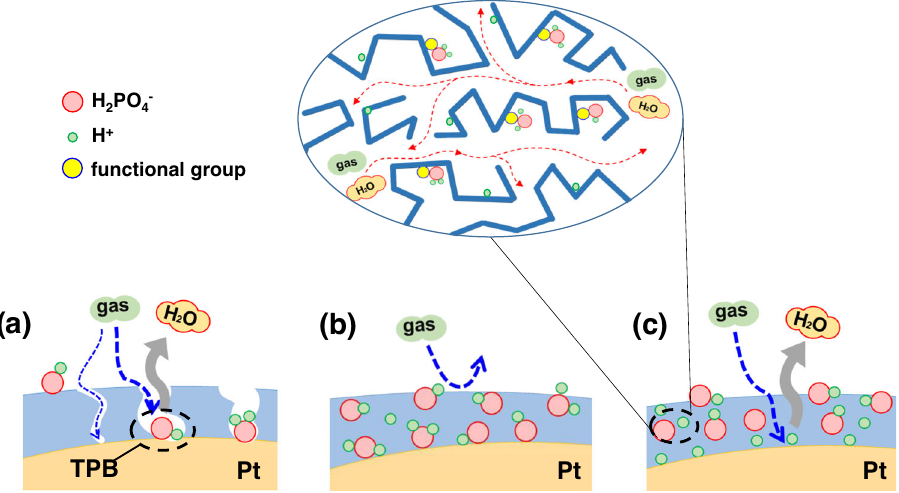
Fig. 1 | Alleviation ofPtcatalystpoisoning from PA fl ooding and enhancement of electrochemical reactivity and Pt utilization at ionic porous-structured interfaces. a At a hydrophobic porous catalysts/electrode surface with binders having less proton conductivity and lowerPA binding energy suchasPTFE, b atan